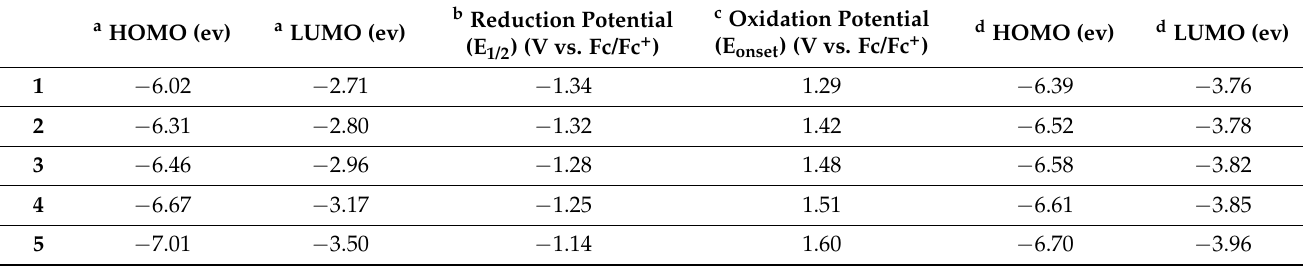
Figure 1. ( a ) The synthesis scheme of the s-tetrazine derivatives. ( b ) The calculated frontier molecular orbital (FMO) energy levels of the s-tetrazines calculated by DFT in solvated system. Table 1. The HOMO, LUMO levels and the redox potentials of